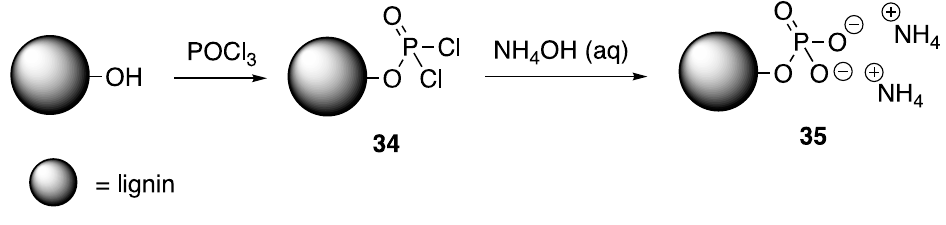
Figure 18. Preparation of 35 .